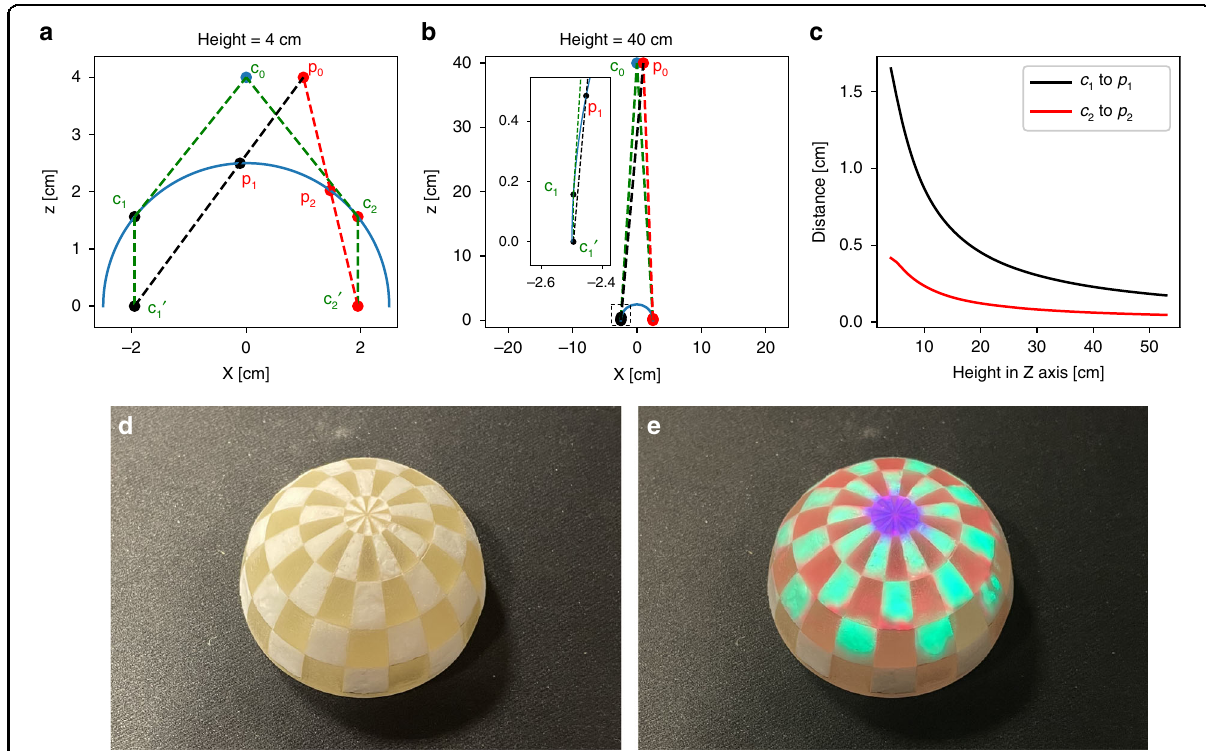
Fig. 5 Characterization of the performance of mixed Raman reality for the hemisphere phantom. a Schematic diagram for the implementing of mixed Raman reality with the hemisphere phantom. Here, taking the section of Y = 0 into account, c 0 and p 0 represent the position of camera and projector, respectively. The horizontal distance between them is fi xed to 1 cm. c 1 and c 2 are the tangent points from c 0 to the phantom. c 1 ′ and c 2 ′ is the base perpendicular from c 1 and c 2 at Z = 0 axis. p 1 and p 2 are the intersections of the hemisphere with the segments of p 0 to c 1 ′ and p 0 to c 2 ′ . b Same consideration for the arrangement, but at a height of 40 cm, where the subimage is the zoom-in of the small black-dashed box. c Height plot in Z axis vs. the distance between c 1 to p 1 (black curve) and c 2 to p 2 (red curve). d Photograph of the hemisphere phantom; and e photograph of the mixed molecular reality image by projecting the molecular image on the phantom. The color information represents the different chemical components, i.e., red for PMMA, green for thermoplastic (polycaprolactone), and blue for